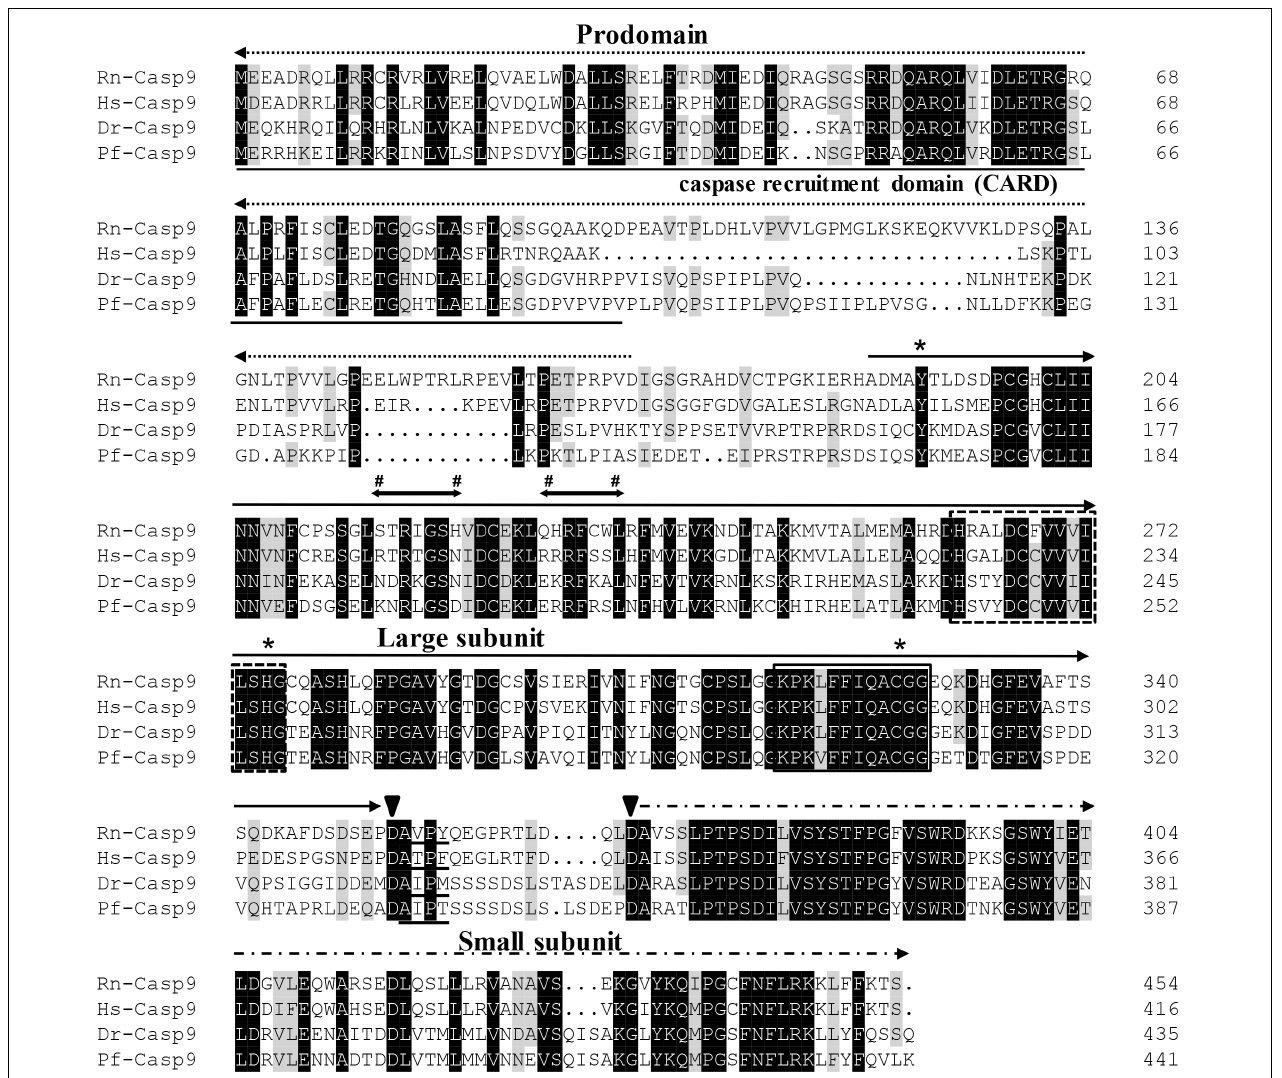
FIGURE 3 | Multiple amino acid sequence alignments of Casp9 genes from P. fulvidraco and other species. Accession numbers as follows [the order is Rattus norvegicus (Rn), Homo sapiens (Hs), Danio rerio (Dr), and Pelteobagrus fulvidraco (Pf)]: Casp9 (ENSRNOP00000017972, ENSP00000330237, NM_001007404.2, KY053837). The putative cleavage site at aspartic acid residues (Asp333 and Asp351), which separates the large subunit ( ) from the small subunit ( ) are indicated by arrowheads. The prodomain is indicated by a dashed line with an arrowhead ( ). The caspase family histidine (residues 242–256) and cysteine active sites (residues 296–307) are boxed in a discontinuous or continuous line, respectively. The first 100 amino acids (caspase recruitment domain, underlined) are a putative N-terminal CARD which are presumably required to bind to Apaf1. Residues below symbols (#) indicate the consensus and putative Akt phosphorylation motifs. The A-X-P-X motifs are underlined. The conserved ‘Tyr,’ ‘His,’ and ‘Cys’ residues are indicated with an asterisk ( ∗ ). The prodomain regions comprise conserved ‘Arg’ and ‘Leu’ residues. Deep and light shadows represent homology of 100 and 75%,